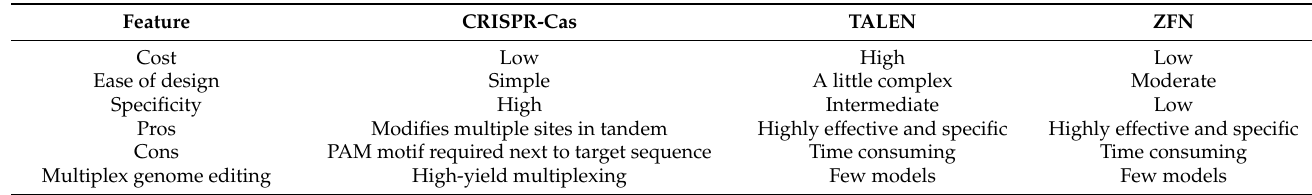
Table 1. Main differences between three genome editing